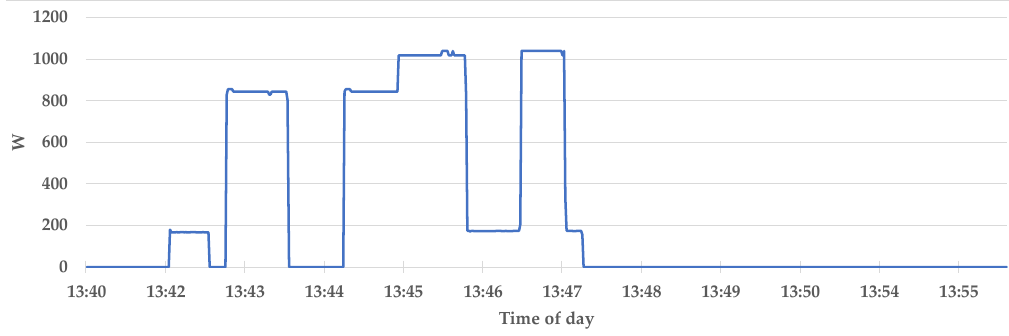
Table 3. Appliances used for experiments.